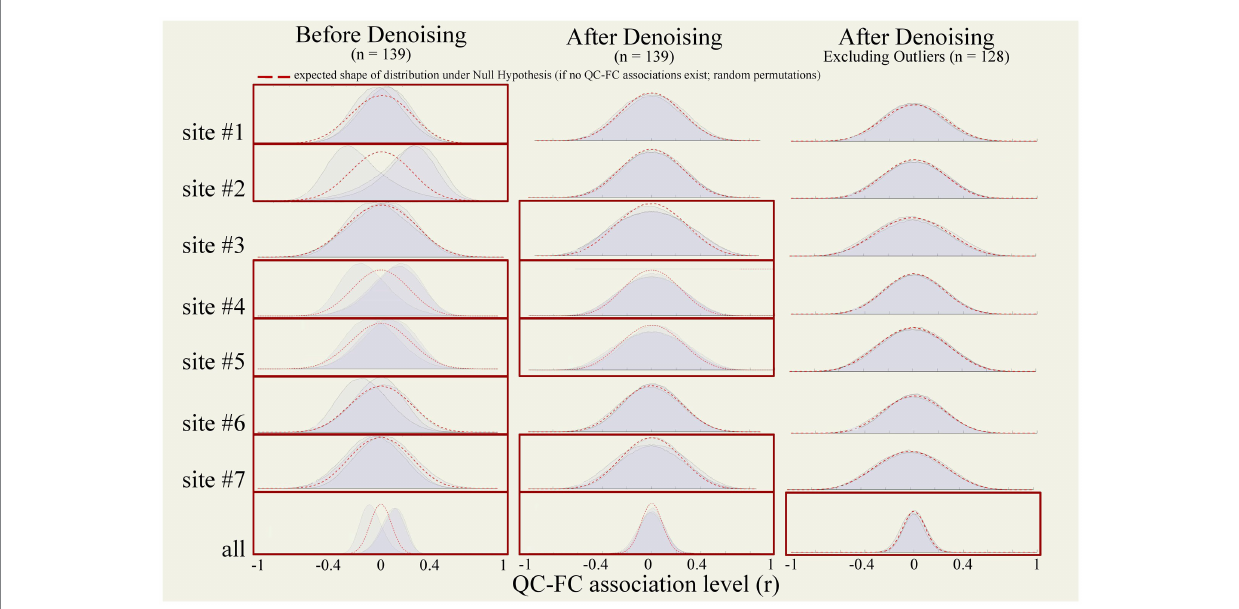
FIGURE 11 QC-FC correlation distributions. QC-FC plots tested functional connectivity associations with three nuisance factors (MeanMotion, InvalidScans, and PVS). Plots were generated from functional data from all participants ( n = 139) before (left) and after (middle) denoising, and after excluding outlier runs (right) identified during raw-level, preprocessed, and denoised data QC ( n = 128). Analyses were performed within each site independently (top) and across all sites jointly (bottom row). Red boxes indicate QC-FC with at least one QC-FC distribution that did not reach above the 95% cutoff. Red dotted lines represent a theoretical artifact-free null-hypothesis distribution. QC, quality control; FC, functional